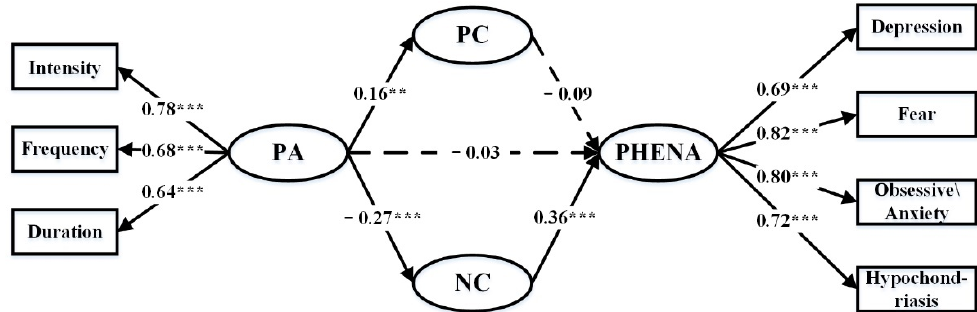
Figure 2. Indirect and mediating effect model. The coefficients in the figure are standardized coefficients. The solid line represents the significant effect of the path, and the dashed line represents the insignificant effect of the path. The ovals and rectangles in this figure do not represent observed variables and latent variables. The ovals are structural variables, and the rectangles are the subdivision dimensions of the structural variable but do not participate in the structural model. *** p < 0.001, ** p <